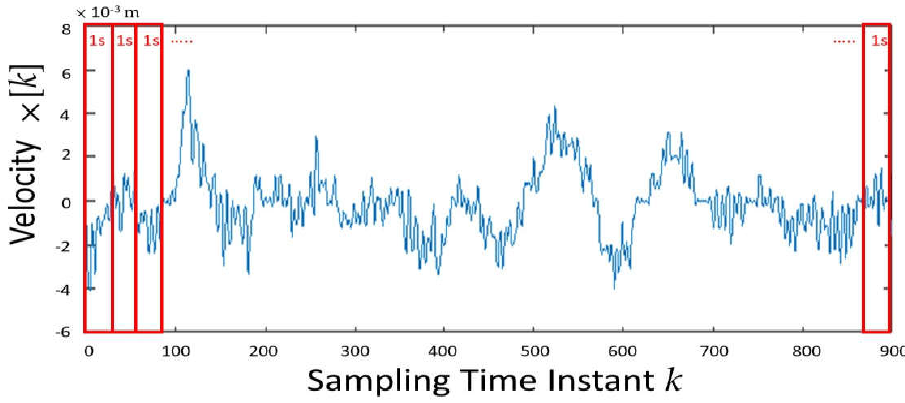
Figure 3. The 30-s time period of a joint velocity signal was divided into 30 one-sec nonoverlapping subintervals.